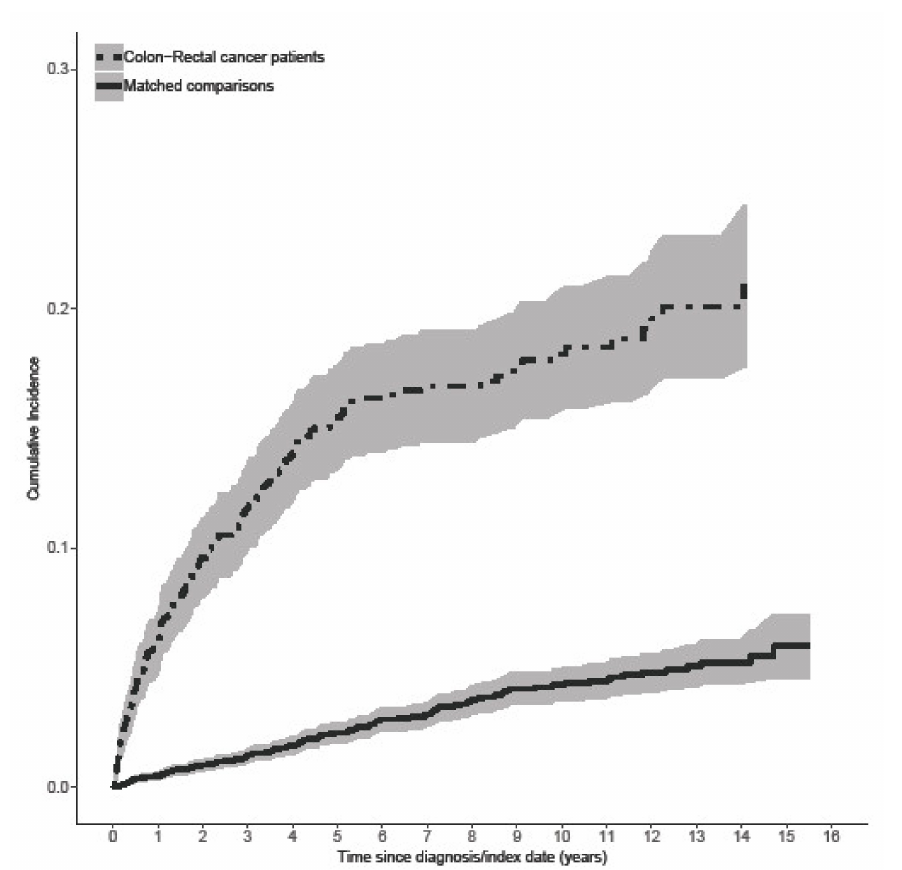
Figure 2. Cumulative incidence functions of hospitalization for depression or antidepressant pre- scription in 1324 patients with colorectal cancer and 6620 matched cancer-free comparison